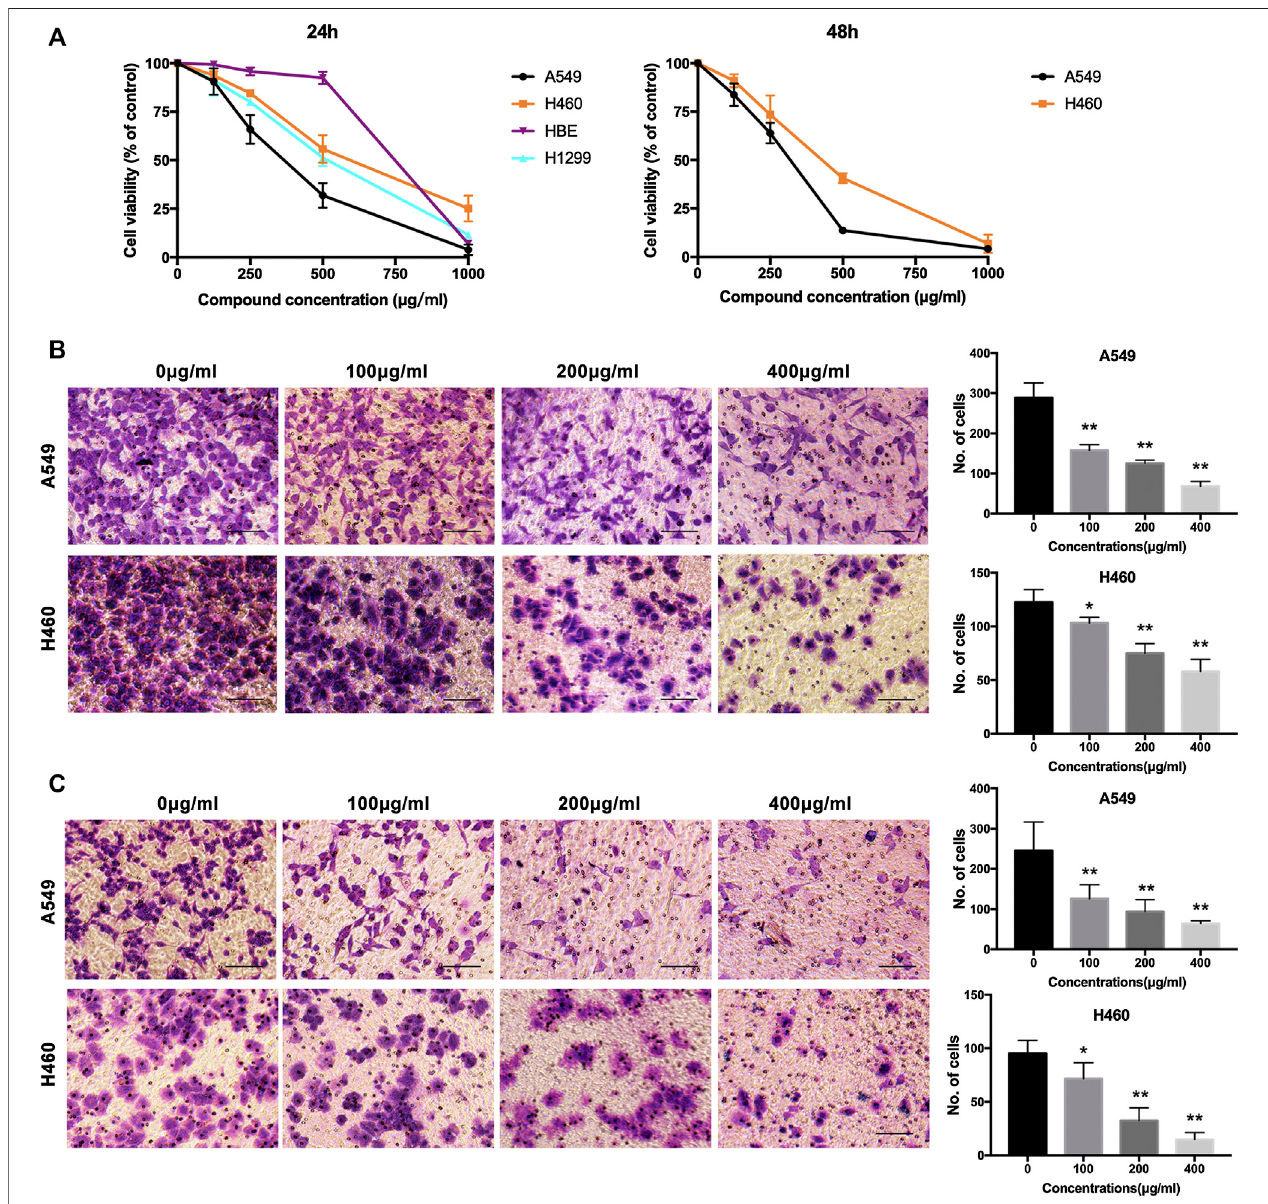
FIGURE1| NWXFreducesviabilityanddampensmigrationandinvasioninNSCLCcells. (A) EffectsofNWXFoncellviabilityinA549,H1299,H460,andHBEcells. Cells were treated with various concentrations of NWXF for 24 and 48 h, respectively. Cell viability was assessed by MTT assays. (B) Migration assays and (C) invasion assays were performed in A549 and H460 cells after pre-treatment with indicated concentrations of NWXF for 24 h. Representative images are shown and the quanti fi cation of four randomly selected fi elds was shown below. Scale bar, 50 μ m. Data were shown as mean ± SD. p p < 0.05, pp p < 0.01 vs. control.